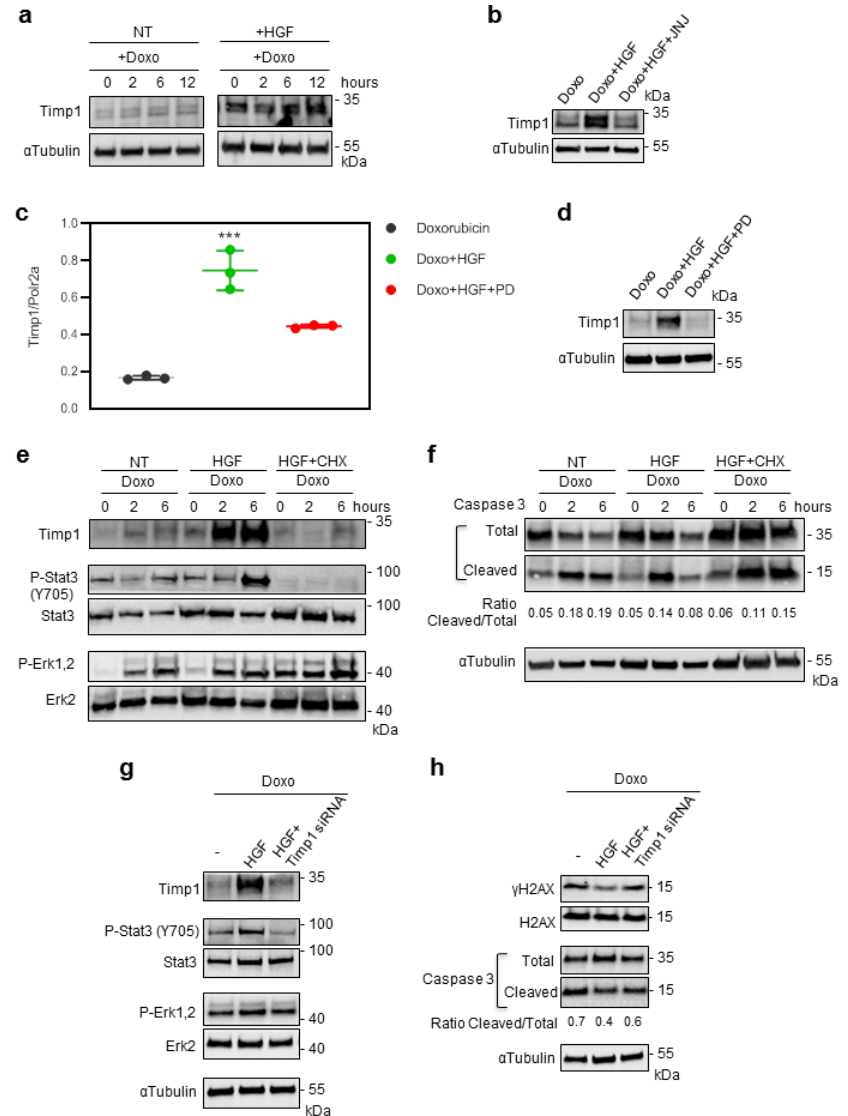
Figure 4. Preconditioning with HGF induces Timp1 (tissue inhibitor of metalloproteinases-1) protein synthesis, which is followed by Stat3 phosphorylation and protection against Doxo-induced apoptosis. ( a ) H9c2 cardiomyoblasts were treated with Doxo (25 µ M) or Doxo + HGF (0.5 nM). For cell treatments, see Figure 1a. Timp1 protein levels were evaluated by Western blotting at di ff erent points of recovery time ( a ). Cells were also treated with ( b ) 500 nM JNJ38877605 Met inhibitor (Doxo + HGF + JNJ) or ( c , d ) 1 µ M PD98059 Erk1,2 inhibitor (Doxo + HGF + PD). Protein ( b , d ) and mRNA ( c ) levels of Timp1 were analyzed after 24 h of recovery time. Polr2a was used as reference gene for the expression data normalization. *** p < 0.005 significantly di ff erent from Doxo-treated cells. ( e , f ) H9c2 cells were pretreated with HGF alone, or with HGF + Cycloheximide (CHX, 10 µ M) for 4 h. Then, Doxo (25 µ M) was added in the last 1 h. The CHX treatment was performed 30 min before adding HGF and was maintained during all the treatment protocol. Protein levels of Timp1, P-Stat3 (Y705), Stat3, P-Erk1,2, Erk2 ( e ) and total and cleaved caspase 3 ( f ) were detected at di ff erent time points of recovery time (0, 2 and 6 h). ( g , h ) H9c2 cells were treated with Doxo (25 µ M), Doxo + HGF (0.5 nM) or Doxo + HGF + Timp1 siRNA. Protein levels of Timp1, P-Stat3 (Y705), Stat3, P-Erk1,2 and Erk2 ( g ) and γ H2AX, H2AX and cleaved / total caspase 3 ratios ( h ) were measured after 24 h of recovery time. The ratios calculated between cleaved and total caspase 3 are shown. α tubulin was used as the loading control in all Western blots. Data are representative results of three independent experimental